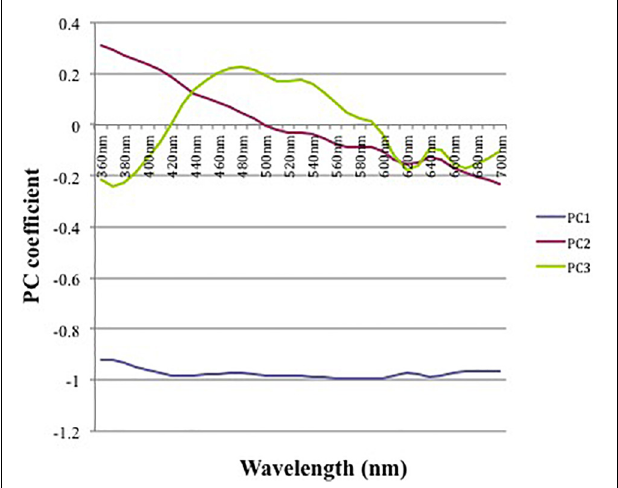
FIGURE 2 | Principal components in relation to wavelength, derived from reflectance spectra from magpie eggs in each clutch. PC1 describes achromatic variation explaining 94.9% of the overall variation. PC2 and PC3 accounted for 85.1% of the chromatic variance. PC2 indicates ultraviolet-red colors and PC3 blue-green